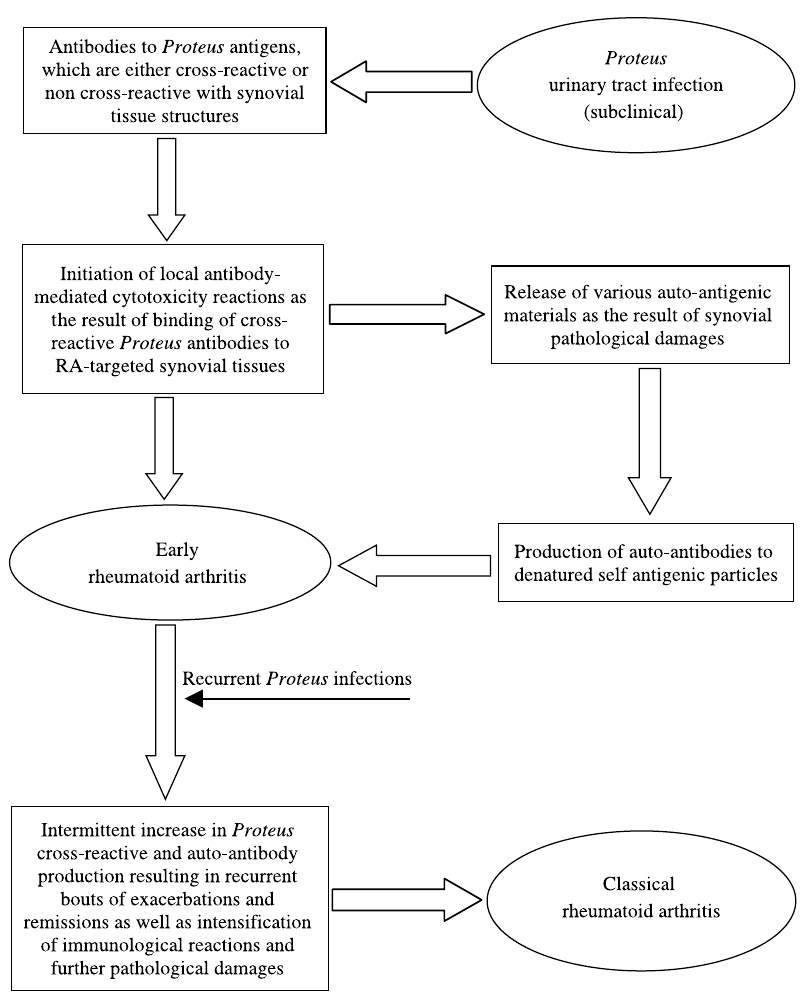
Figure 1. Schematic representation of pathological steps in the development of rheumatoid